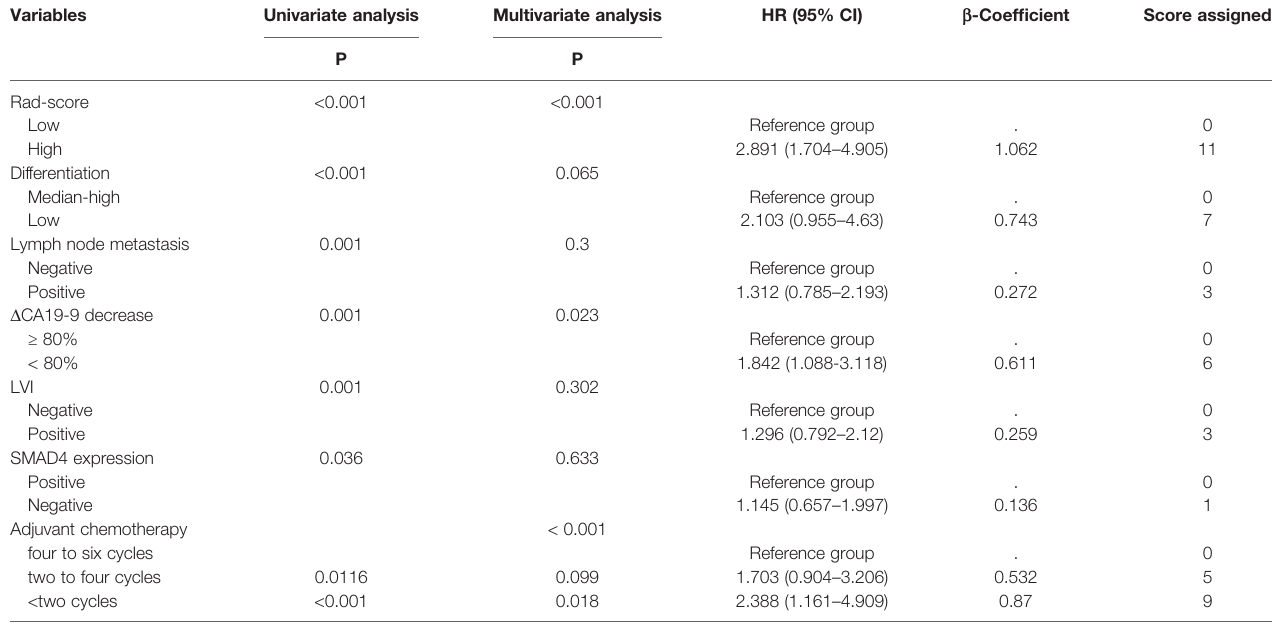
TABLE 2 | Construction of a risk-strati fi cation system for risk strati fi cation in RPC patients. Variables Univariate analysis Multivariate